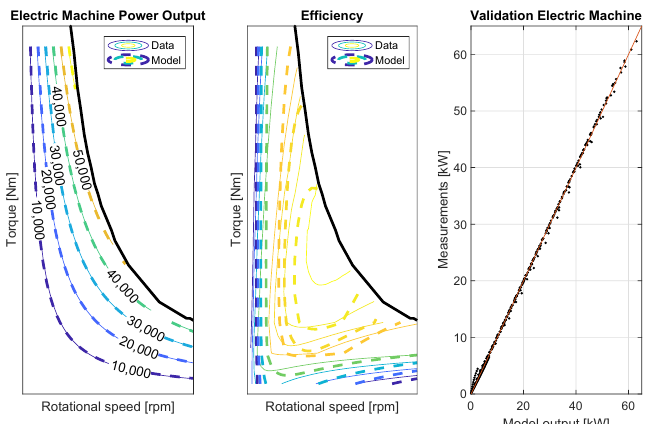
Figure 4. Electric motor power output and efficiency, and a comparison of the model’s power output and the measured power output. Note that the highest efficiency island is not captured by the model.